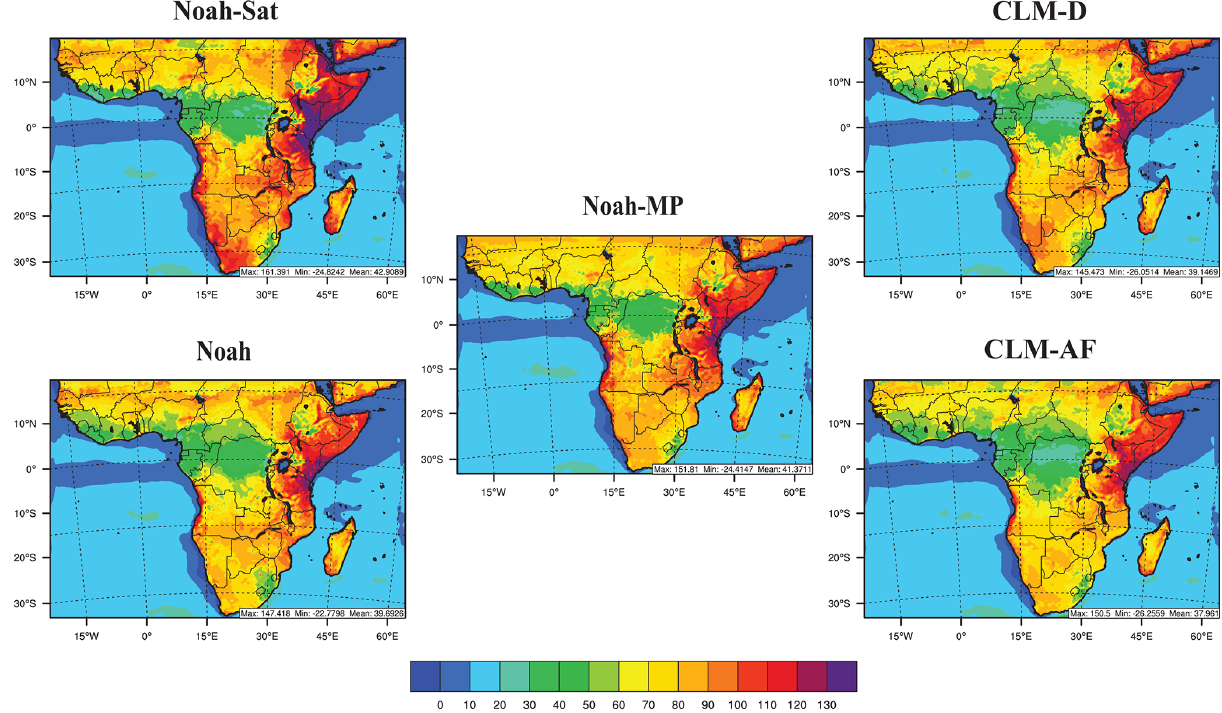
Figure 6. Comparison of annual average sensible heat flux (Wm − 2 ) between LSM configurations.